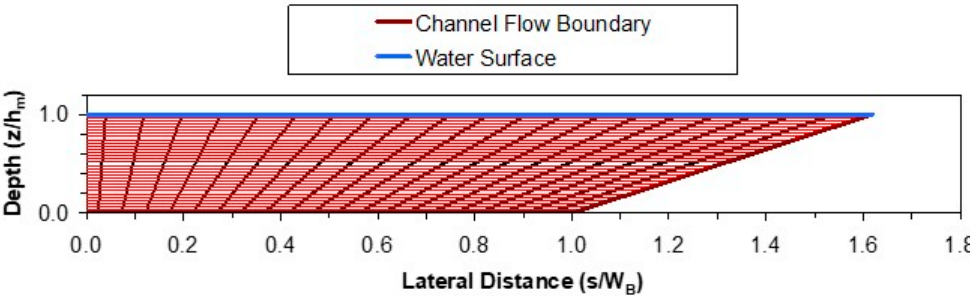
Figure A7. Cross-sectional right half of the 3D structured mesh (492 × 42 × 32) at Cross-section 6, three-fourths of the way through the upstream channel curve.